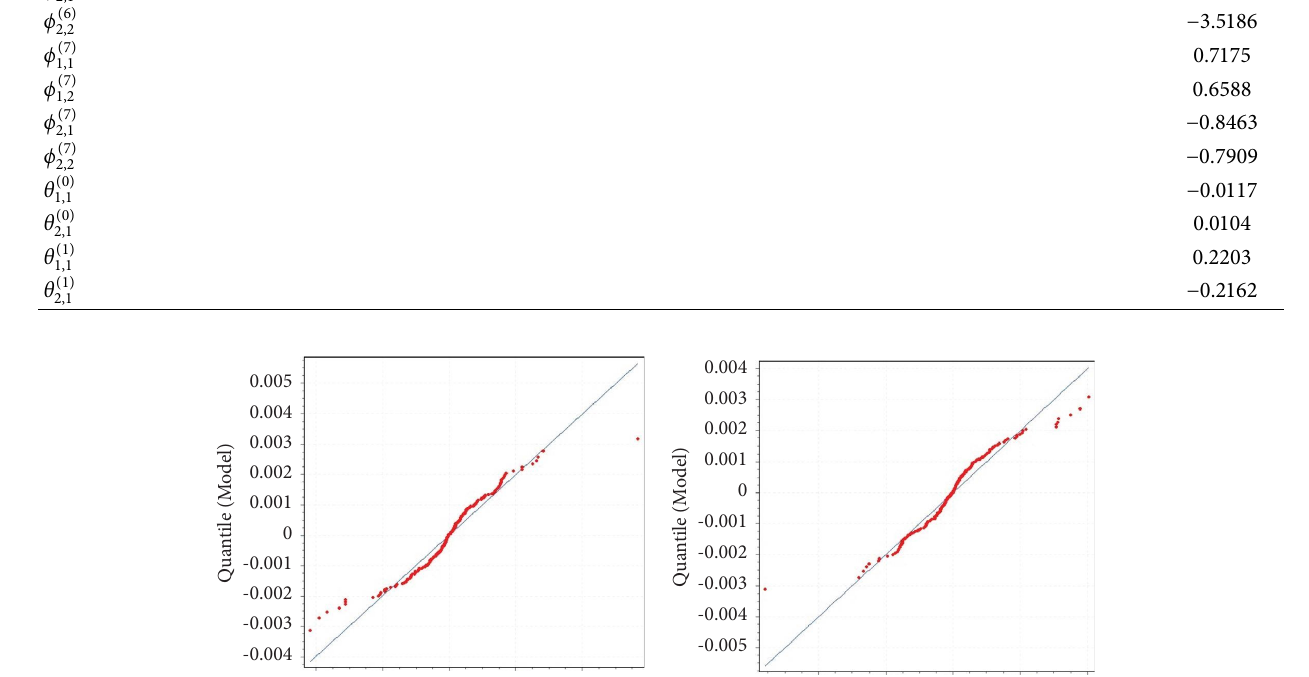
(a) and e 1 ,t 2 ,t